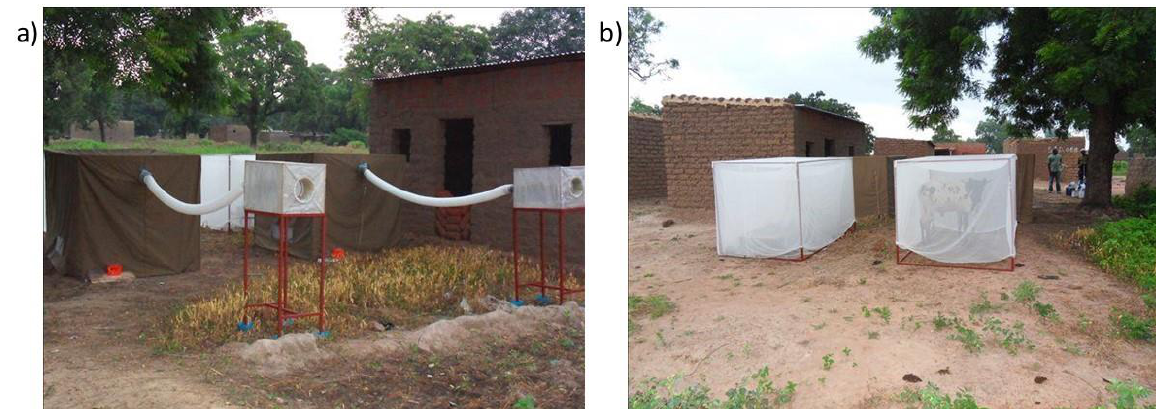
Figure 1. Traps baited with calf and human odours used to assess the host preference of field populations of mosquitoes in Samandeni and Klesso villages. a) Two odour-baited entry traps (OBETs) were connected to a tent by air vent hoses. b) Two odour-baited double net traps